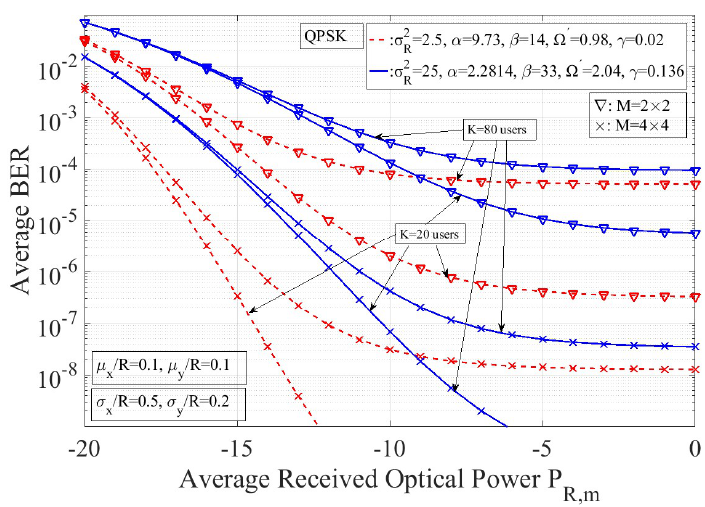
Figure 6. The ABER performance for the reverse CDMA RoFSO link with receivers’ diversity, over strong turbulence and enhanced PE impact for different values of the number of users K .